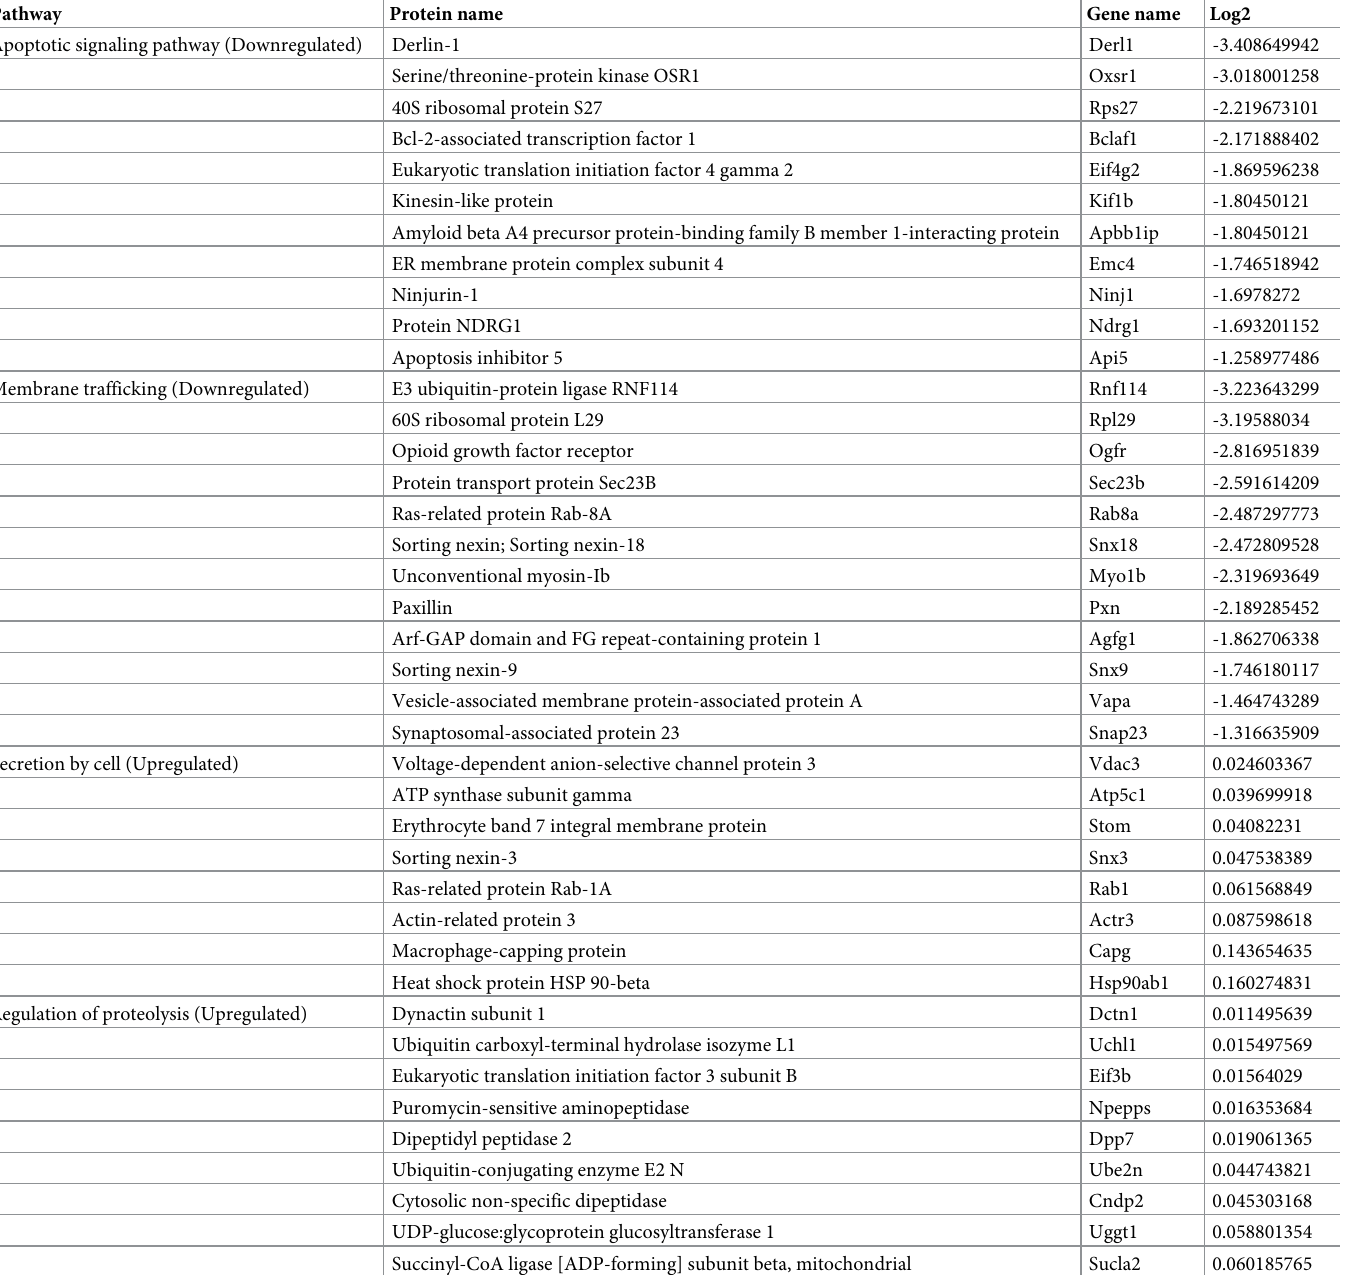
Table 1. Identification of the top-hit pathway proteins that were downregulated and upregulated in E . histolytica -induced hyperactivated macrophages.